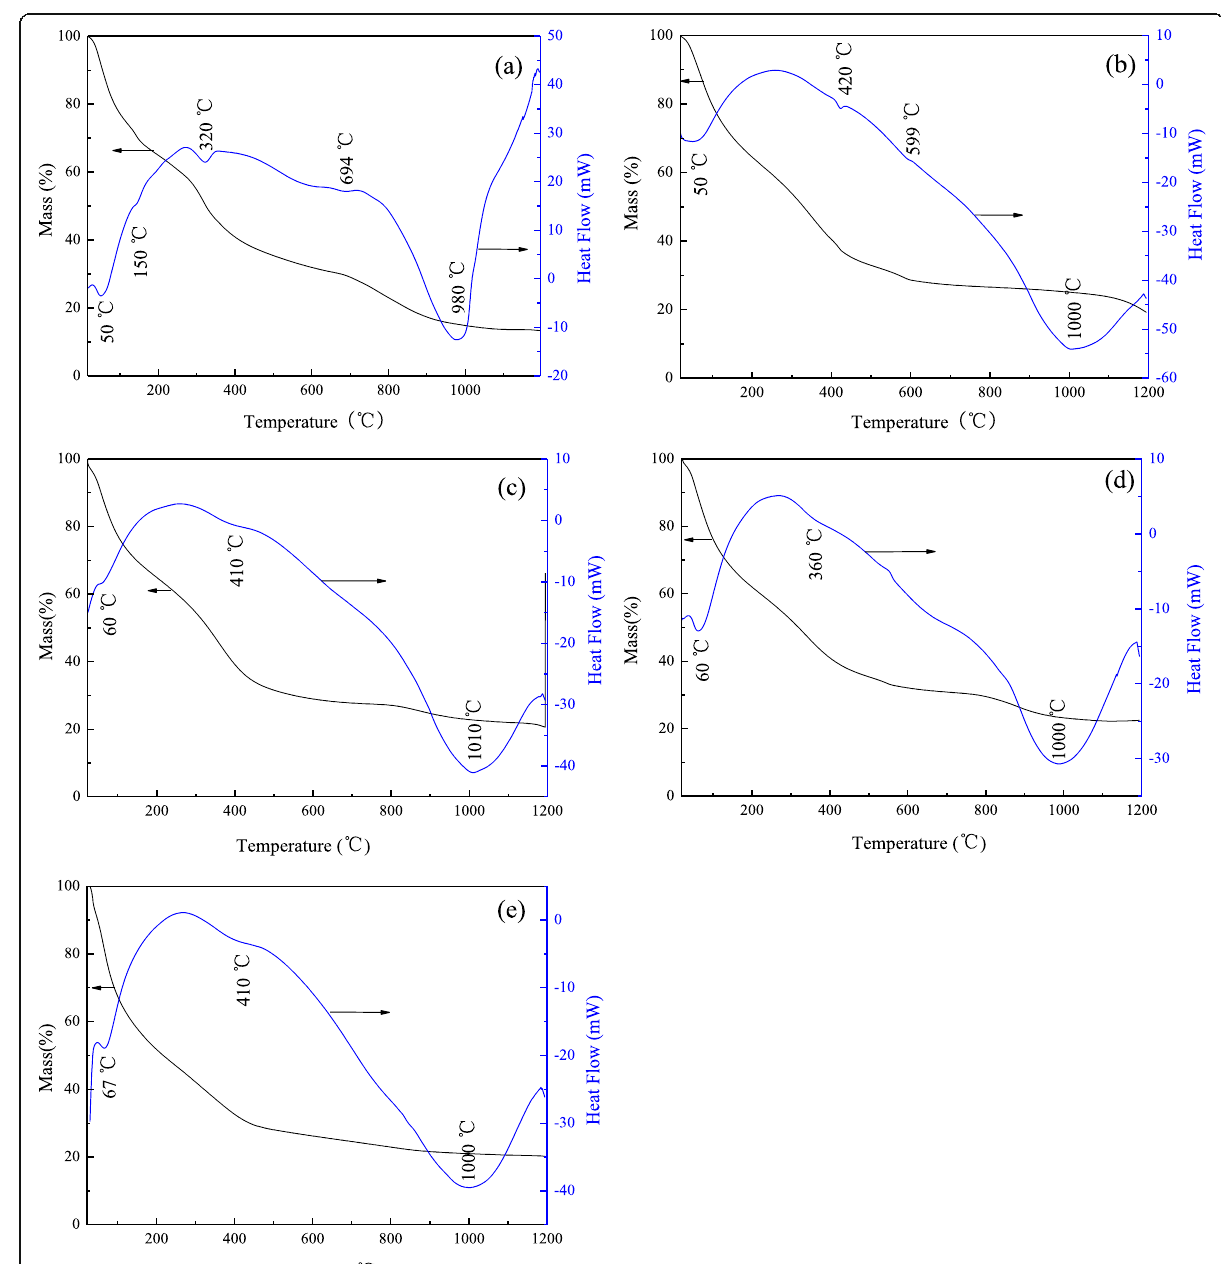
Fig. 3 TG and DSC of the nano alumina rod precursors doped with different ions: a undoped alumina, b Cr-doped alumina, c Fe-doped